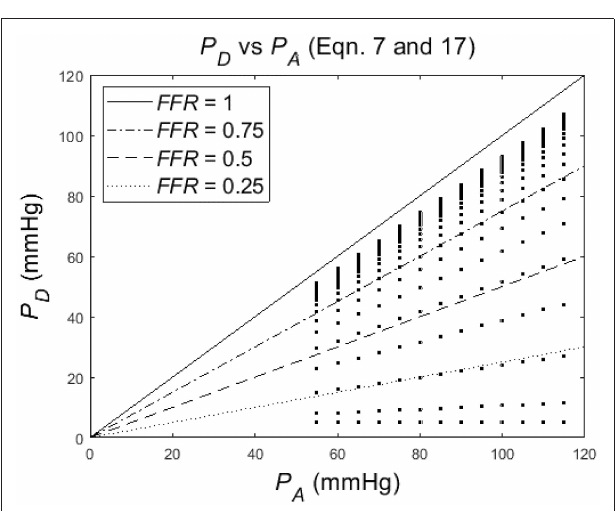
FIGURE 4 | Simulation of distal-to-stenosis pressure P D vs. mean aortic pressure P A (Equation 17) with each dot representing a case with P A running from 55 to 115mmHg for different values of the degree of stenosis α ( α running from 1 to 0), and with lines (Equation 7) indicating FFR at 1, 0.75, 0.5, and